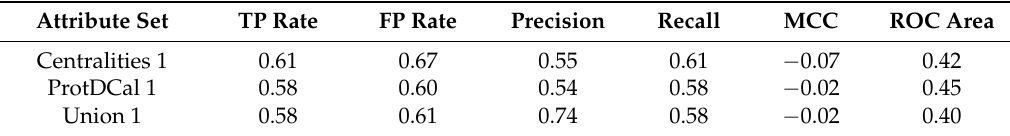
Table 3. Swapped Test for JAMMING1SET Best Models.